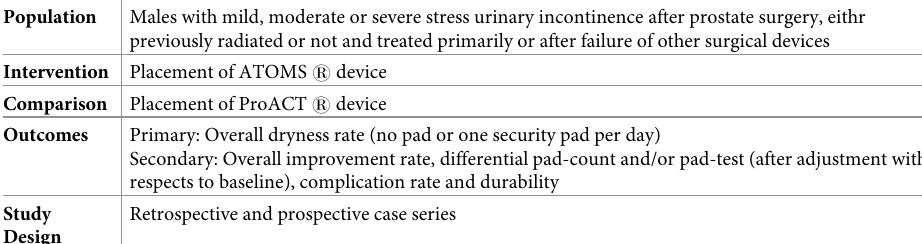
Table 1. PICOS criteria to guide the systematic